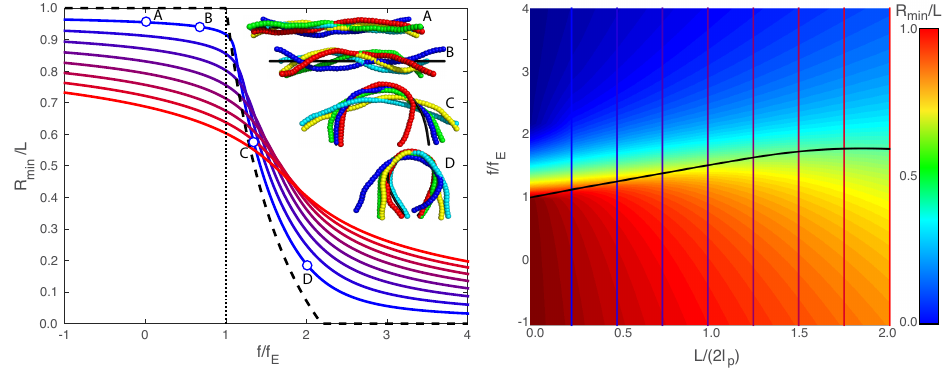
Figure 2. The left side shows the minimum free-energy end extension R min versus external force f / f E for values of L / ( 2 l p ) ranging from L / ( 2 l p ) = 0.25 (blue curve) to L / ( 2 l p ) = 2 (red curve). For L / ( 2 l p ) = 0.25, the top plot includes pre-buckling (marked A and B ) and post-buckling (marked C and D ) conformations calculated via Monte Carlo simulation at the same force values as in Figure 1. The right side shows a surface plot of R min ( R min / L = 1 in red to R min / L = 0 in blue as indicated by the colorbar) versus f / f E and L / ( 2 l p ) . The vertical lines indicate the L / ( 2 l p ) -value slices that are plotted in the top plot. The black curve on the bottom surface plot gives the critical buckling force made dimensionless by the zero-temperature critical force f c / f E versus L / ( 2 l p ) .